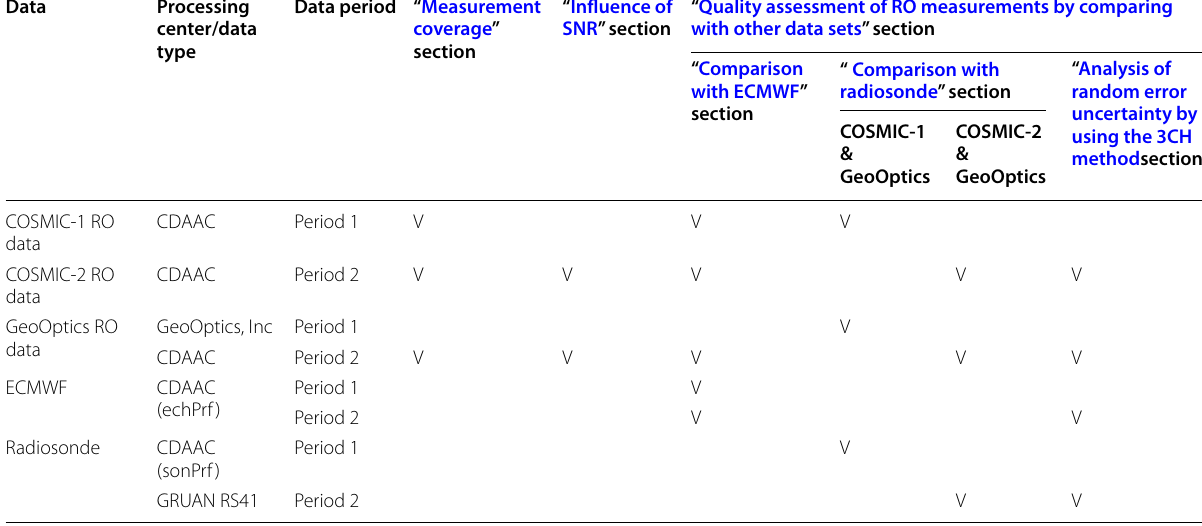
Table 2 Data sets used in each